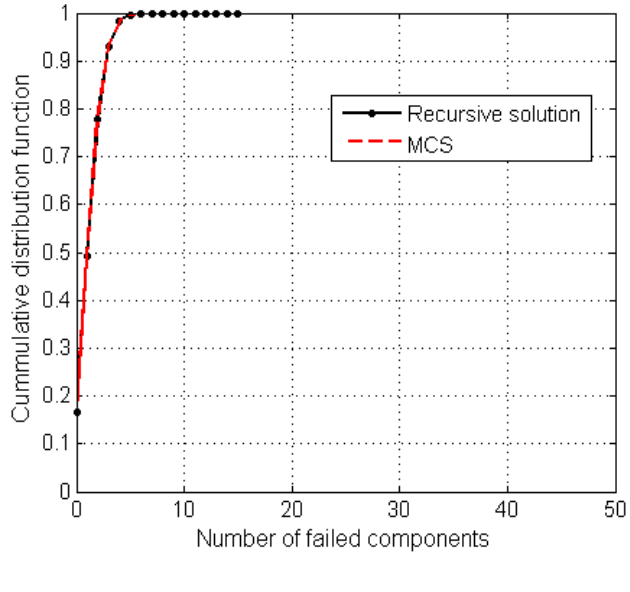
Figure 6. Comparison of annual system failure CDFs obtained for 45-component wind turbine by the recursive solution and a naïve Monte Carlo simulation (MCS)